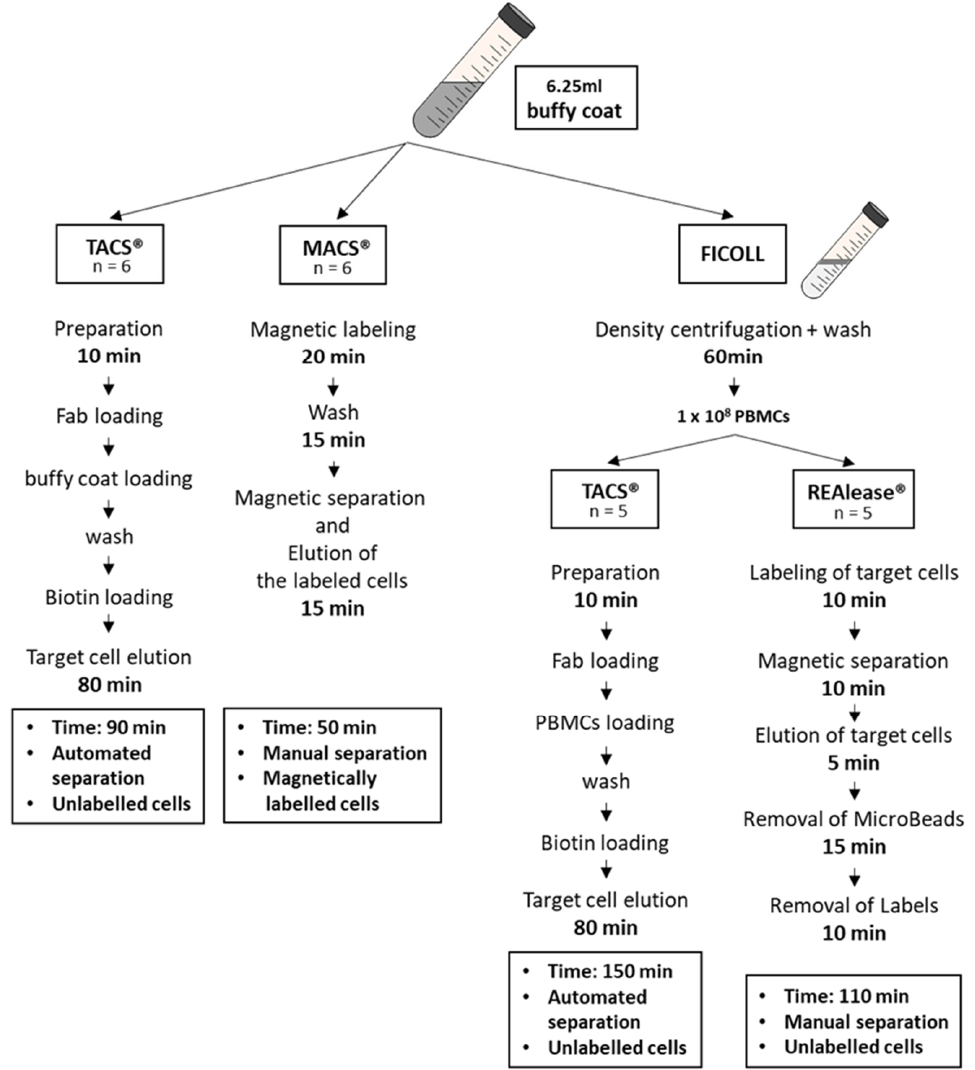
Figure 1. Overview of the isolation protocols. CD3-positive cells were either isolated from buffy coats using the MACS ® and TACS ® technology or from buffy coat-derived PBMCs using the TACS ® and REAlease ® system. Shown are the different procedures used to isolate CD3-positive T cells.